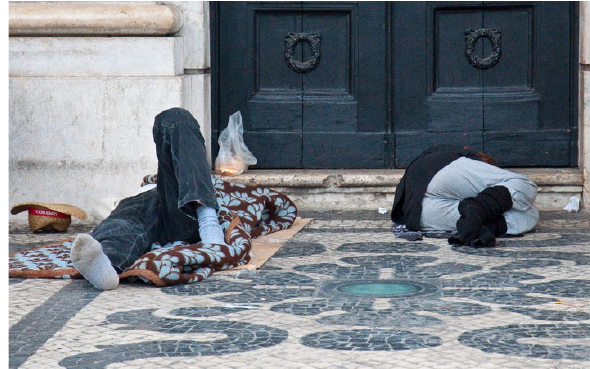
Figure 10. Photograph clearly classified as “Useful” regarding the keyword “Homeless” (Flickr, 2018b)